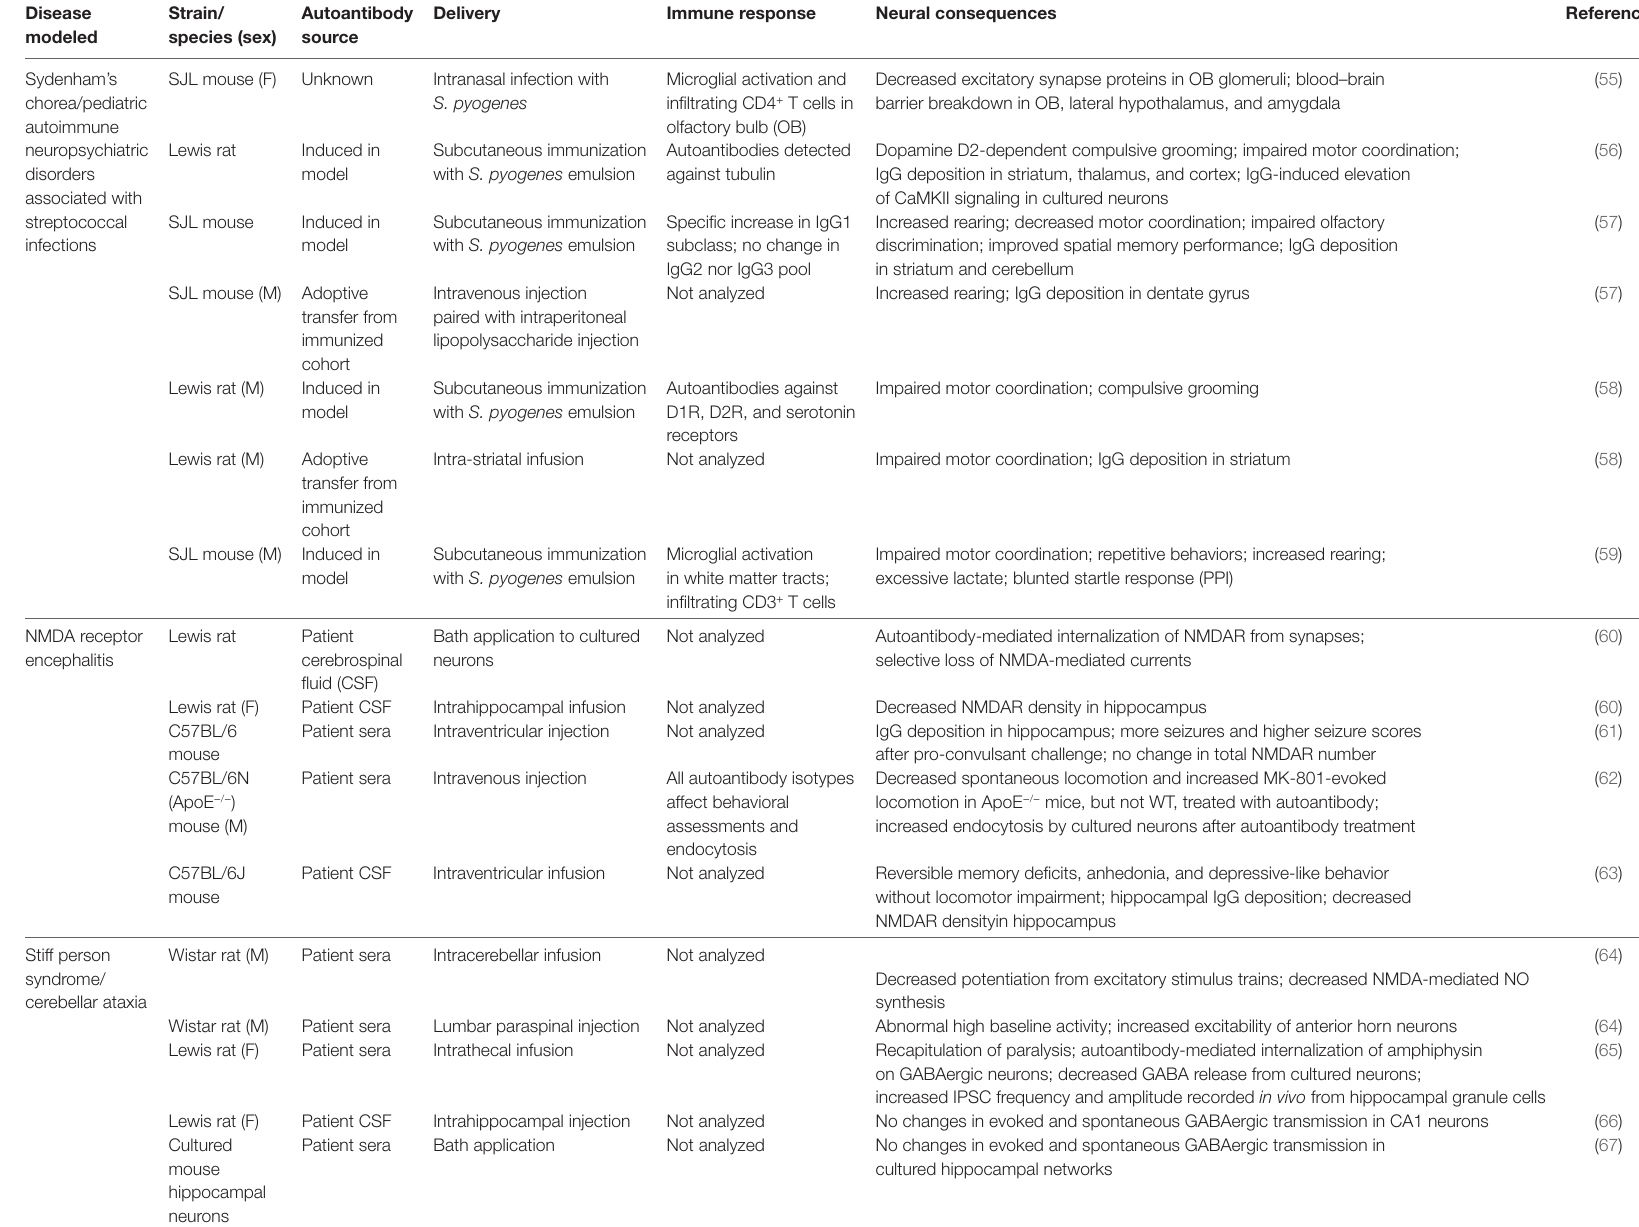
TABLe 1 | Summary of published rodent models for several autoimmune